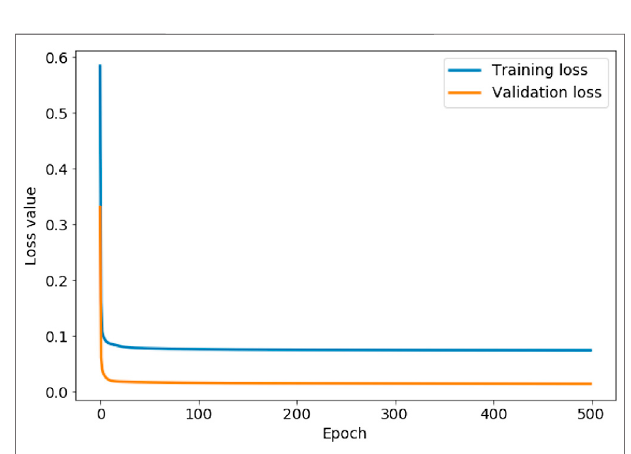
FIGURE 4 | The evolution of the training loss value and validation loss value as the autoencoder iterates through 500 steps (epochs).